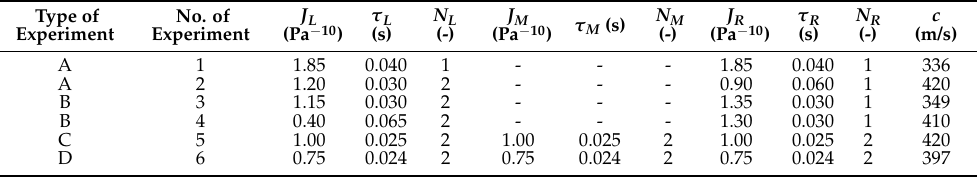
Table 2. Viscoelastic and transient flow parameters used as an input for the numerical model. Type of